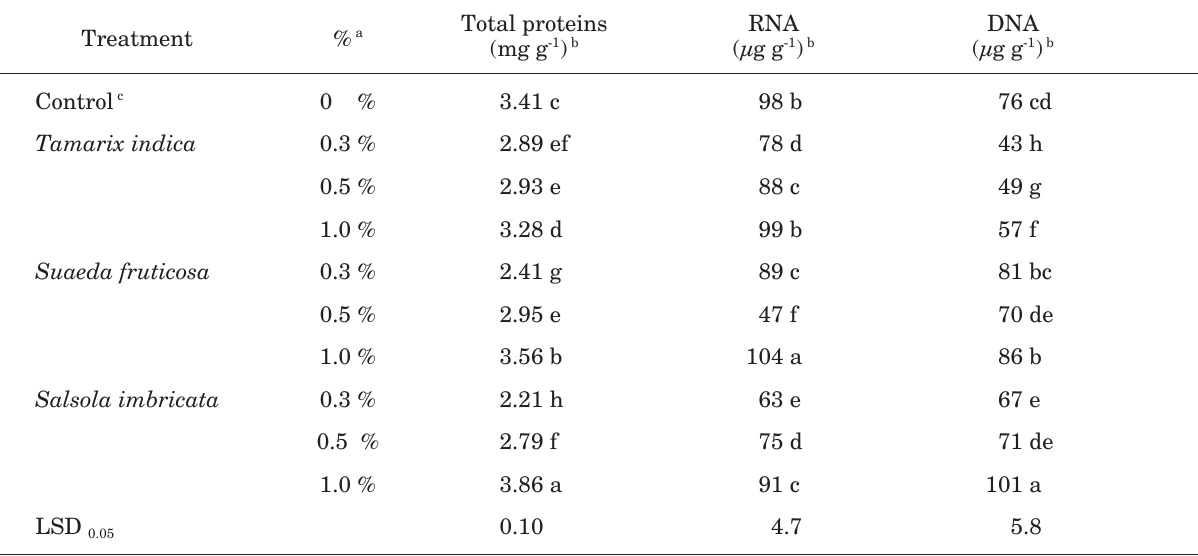
Table 6. Effect of three halophytes on total proteins and nucleic acid contents of eggplant infected with Meloidogyne javanica .